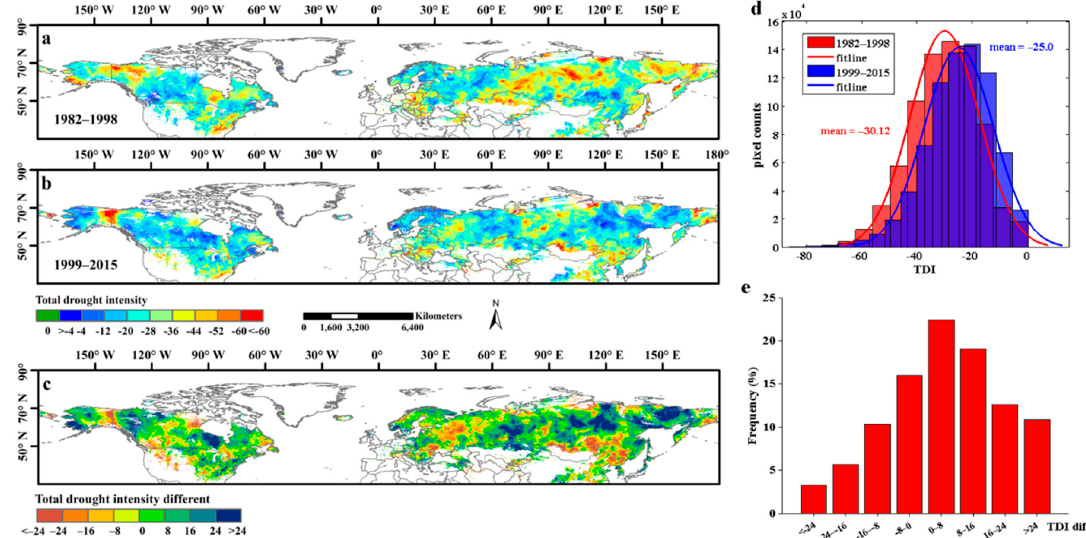
Figure 7. The spatial distribution of total drought intensity (TDI) of each pixel in Northern